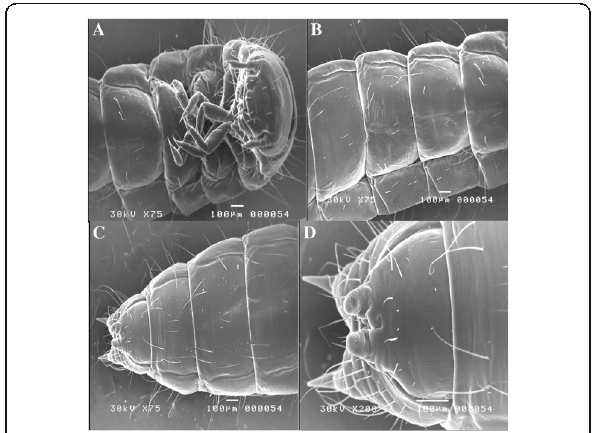
Fig. 7 a – d SEM of last larval instar of T. confusum